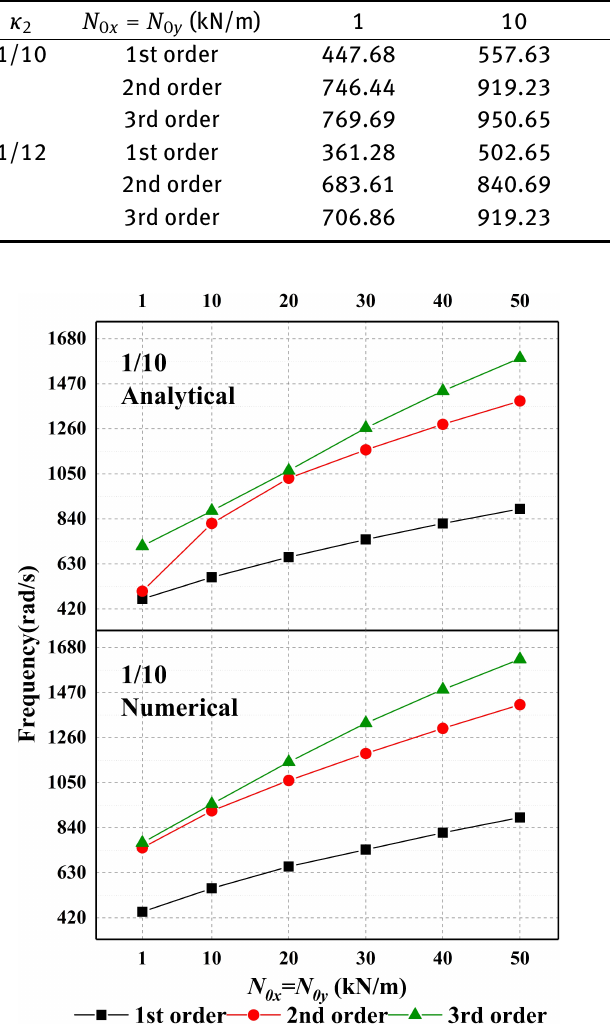
Figure 8: Comparison of natural frequencies under different pre- stressing conditions when the rise span ratio is